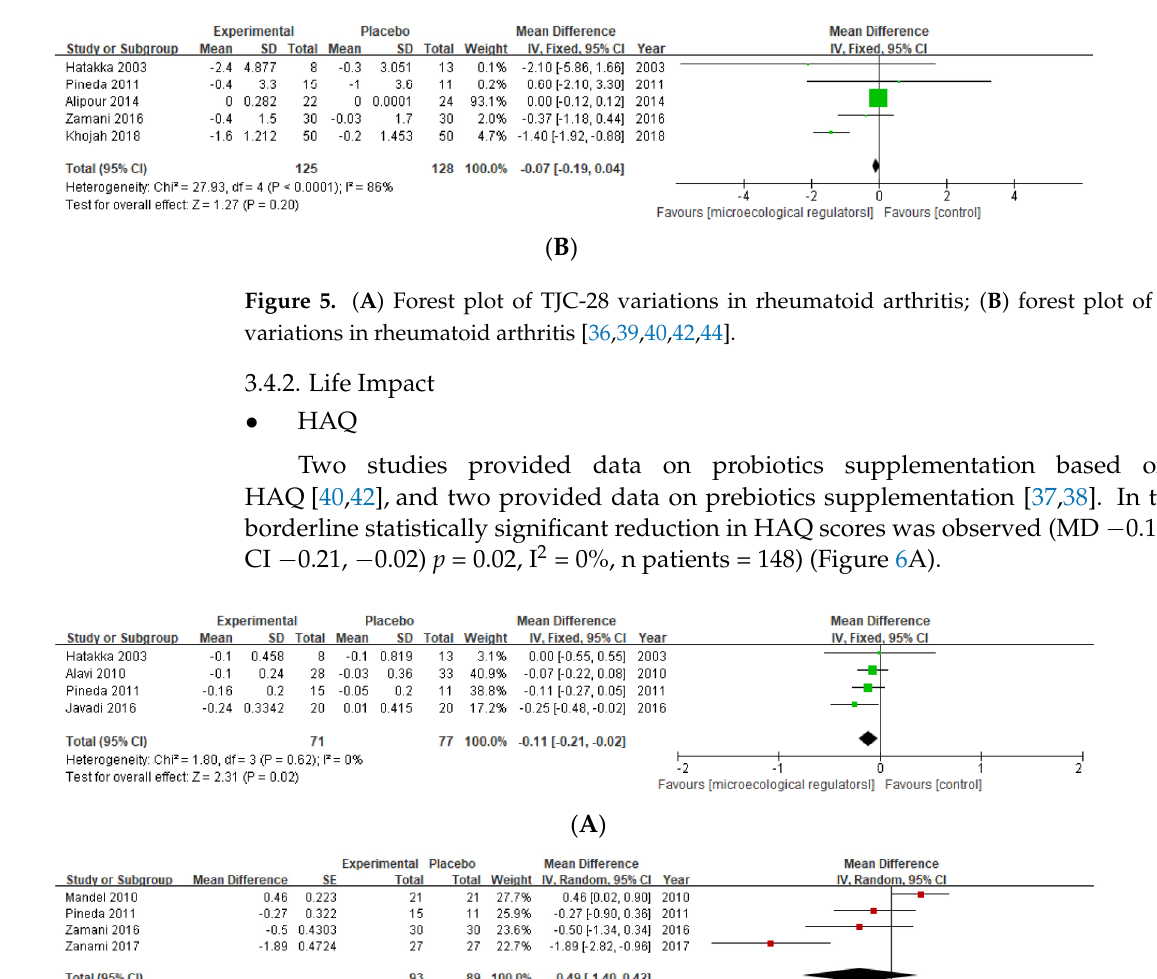
Figure 6. ( A ) Forest plot of HAQ variations in rheumatoid arthritis; ( B ) forest plot of pain—VAS variations in rheumatoid arthritis [37–42,45].